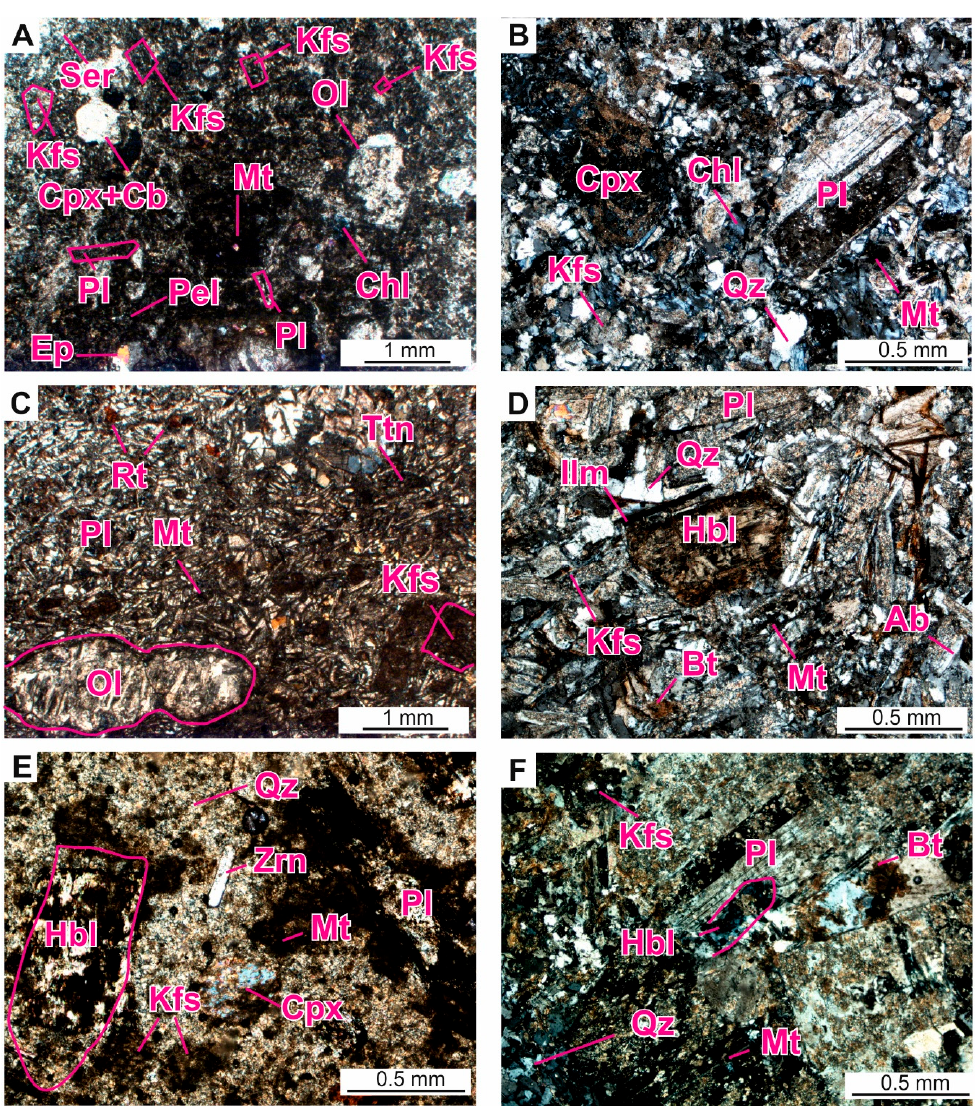
Figure 4. Thin section photographs of rocks from dikes (crossed nicols): ( A ) sample V3-9, trachybasalt; ( B ) sample Sh-215, andesite; ( C ) sample Sh-25, trachyandesite; ( D ) sample Sh-39, trachyandesite; ( E ) sample VK-127, dacite; ( F ) sample Sh-26, granodiorite. Abbreviations of minerals names from